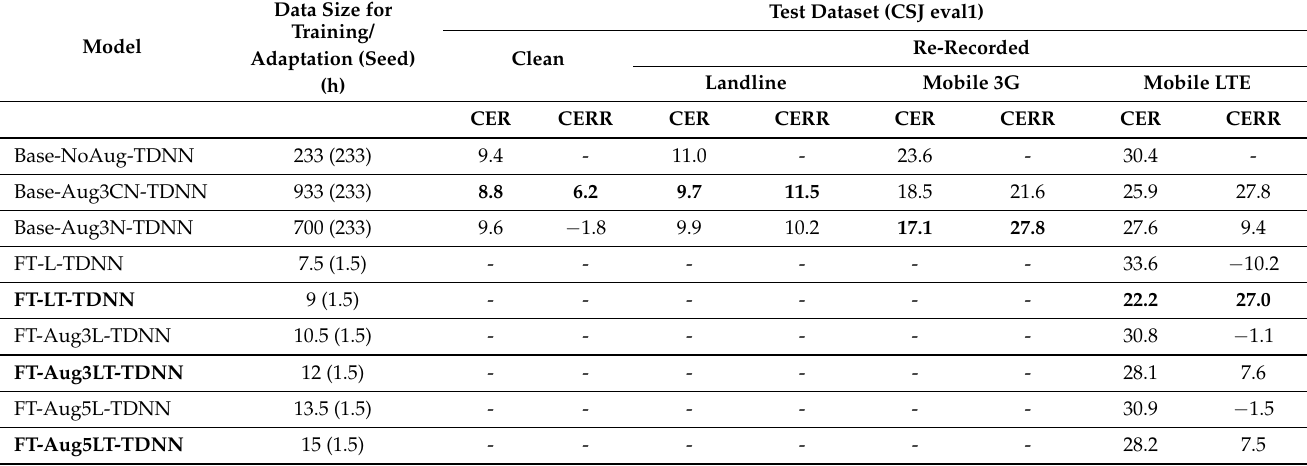
Table 5. Telephone speech: character error rate (CER%) of different TDNN ASR models and character error reduction (CERR%) from Base-NoAug-TDNN. The notation “-” denotes “not applicable”. The expressions with bold font represent the models trained with proposed fine-tuning method. The bold numbers represent the best result for each test